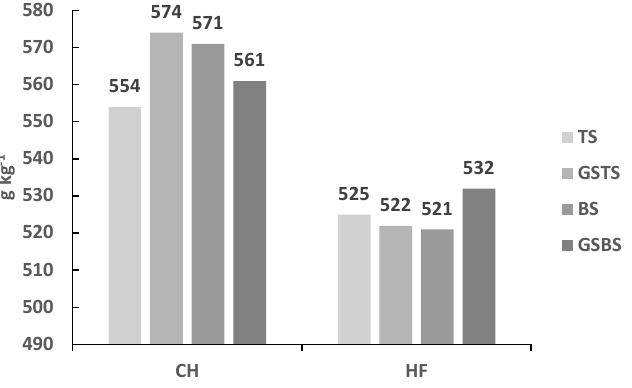
Fig. 2. Differences between Charolais (CH) and Hereford (HF) in dressing proportion (g kg -1 ) response to the partial replacement of triticale silage (TS) or barley silage (BS) with grass silage (GS) in total mixture rations (interaction p <0.05; breed × contrast 5) (SEM =